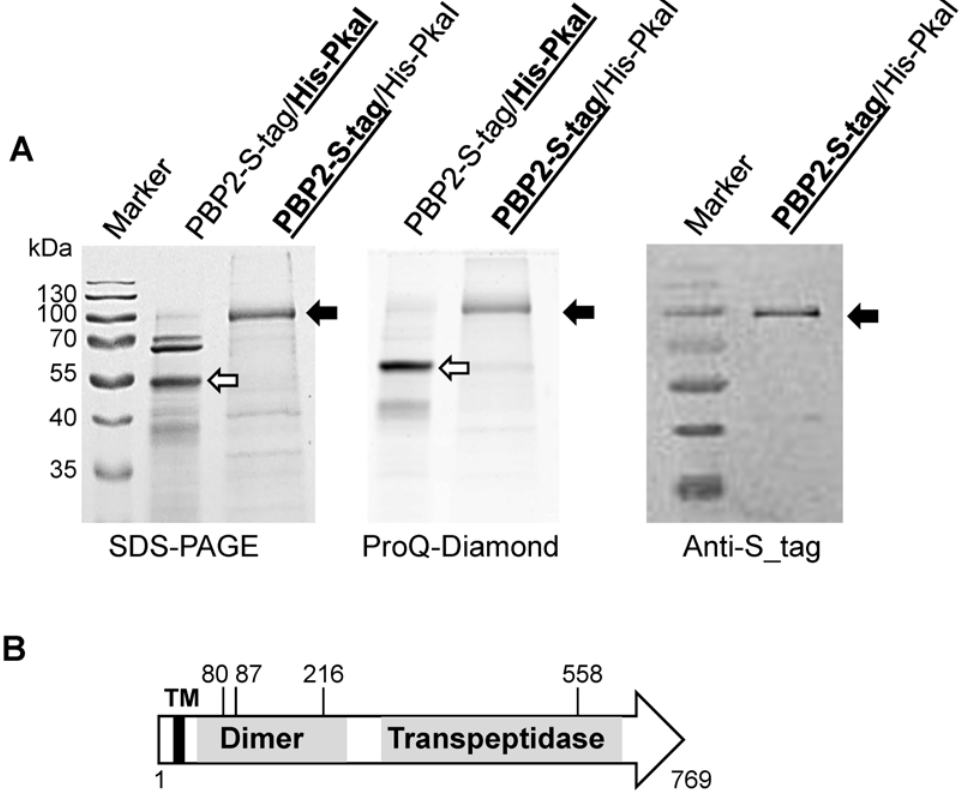
Fig 5. Phosphorylation of PBP2 by PkaI. S . coelicolor pbp2 with a S-tag encoding sequence was co-expressed with pkaI in E . coli . PBP2_S-tag was purified under denaturing conditions by affinity chromatography. PkaI with an N-terminal His-tag was purified by Ni-NTA chromatography under native conditions. Purified His_PkaI and PBP2_S-tag proteins (bold letters and underlining indicate, which protein was purified) were separated on an SDS polyacrylamide gel and stained with Coomassie blue ( A ). Phosphorylated proteins were identified by ProQ Diamond staining. The white arrow indicates auto- phosphorylated His_PkaI, while the black arrow marks phosphorylated PBP2_S-tag. Immunoblotting with Anti-S-tag antibodies confirmed the identity of PBP2_S-tag. Domain architecture of PBP2 and positions of the most likely phosphosites ( B ). Predicted Pfam domains (PBP dimerization, dark grey, PBP transpeptidase, light grey), a transmembrane helix (TM) and the positions of phosphorylated S/T residues, identified by LC-MS/MS, are indicated.